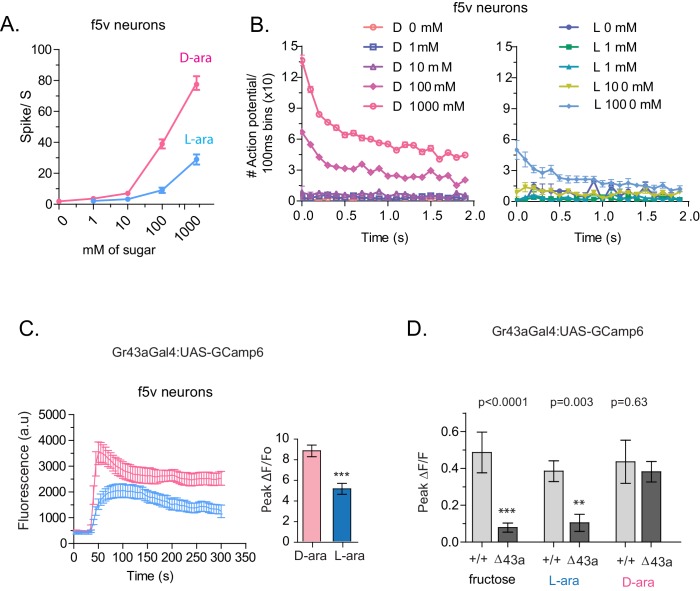
Tarsal Gr43a neurons respond differentially to D- and L-arabinose.(A) Spikes per second of recorded f5V tarsal neuron in response to D- or L-arabinose at various concentrations. (B) Spikes per second binned by 100 ms over the first two seconds of response. (C) The evoked-calcium activity of Gr43aGAL4 neurons in the distal tarsi. (D) Removal of Gr43a receptor impairs fructose and L-arabinose activation of Gr43aGAL4 neurons. Results with error bars are means ± s.e.m. ns, not significant. *≤0.01, **≤0.001 and ***≤0.0001.